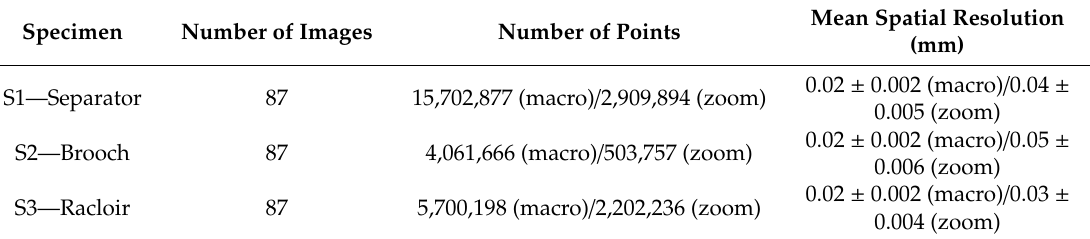
Table 5. Summary of the reconstruction process.